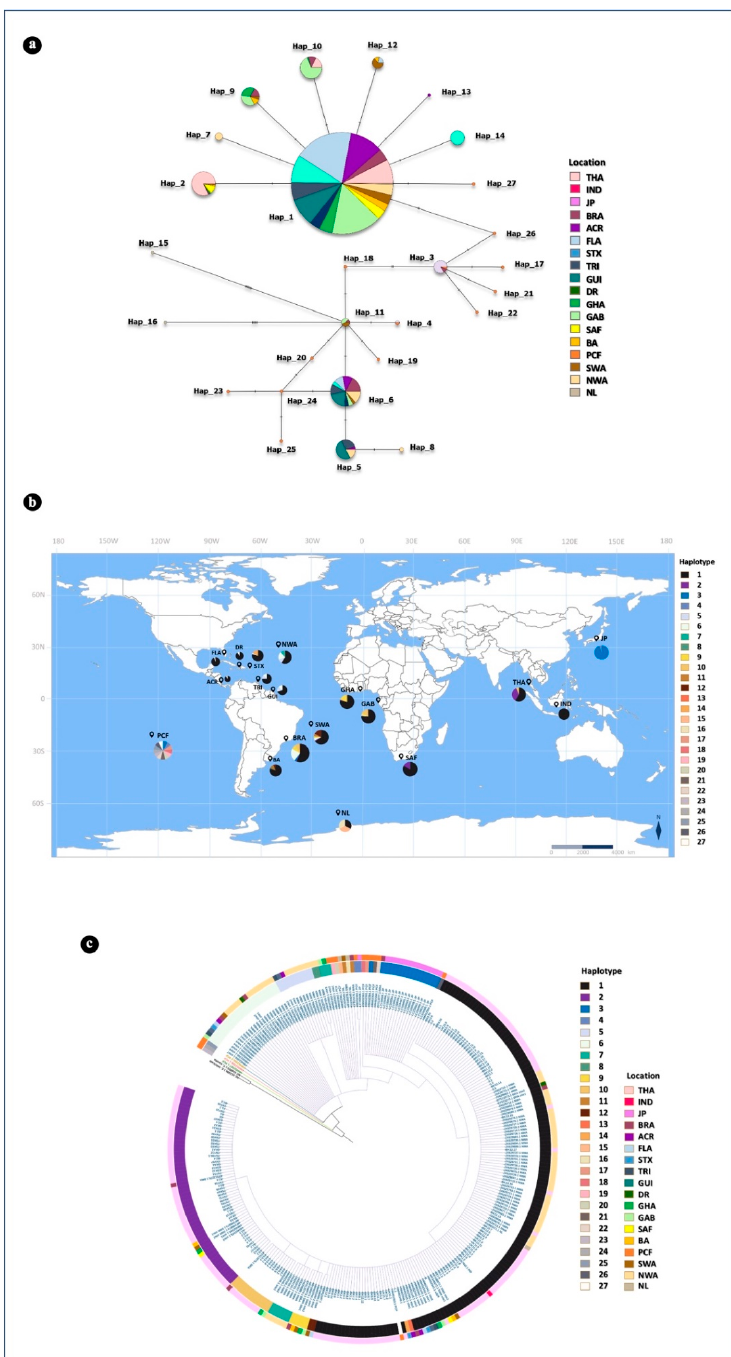
Figure 4. Median-joining network (MJNs) based on 658 bp of mtDNA control region. ( a ) MJNs of mtDNA control region 658 bp of the global leatherback turtles ( b ), geographic distribution of leatherback turtle haplotypes in the global scale ( c ), and phylogenetic tree of global leatherback turtle haplotypes. Leatherback turtle populations were divided into four clades: A (1 sequence: green branch); B1 (1 sequence: pink branch); B2 (1 sequence: blue branch); and B3 (291 sequences: purple branch). The inner color circle indicates haplotype and the outer circle indicates location—Thailand (THA), Indonesia (IND), Japan (JP), Brazil (BRA), Costa Rica (ACR), Florida (FLA), St. Croix (STX), Trinidad (TRI), Guiana (GUI), Dominican Republic (DR), Ghana (GHA), Gabon (GAB), South Africa (SAF), Buenos Aires (BA), Pacific (PCF), Southwest Atlantic (SWA), Northwest Atlantic (NWA), No location